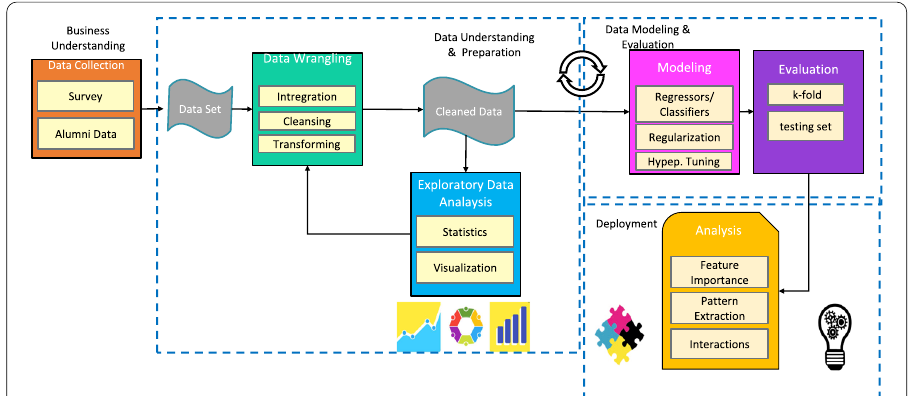
Fig. 1 The Knowledge Discovery Process flow diagram employed in this work and linked to the CRISP‑DM